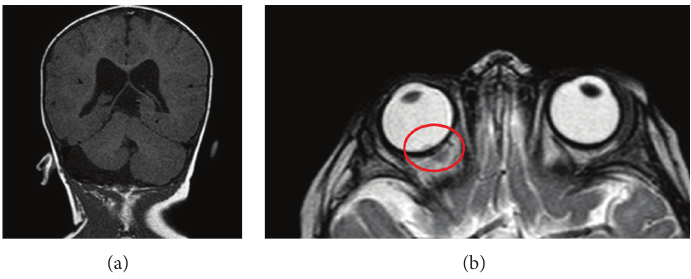
Figure 2: Right cerebellar and vermis hypoplasia plus a 2 mm length tumor of the retina (retinoblastoma).